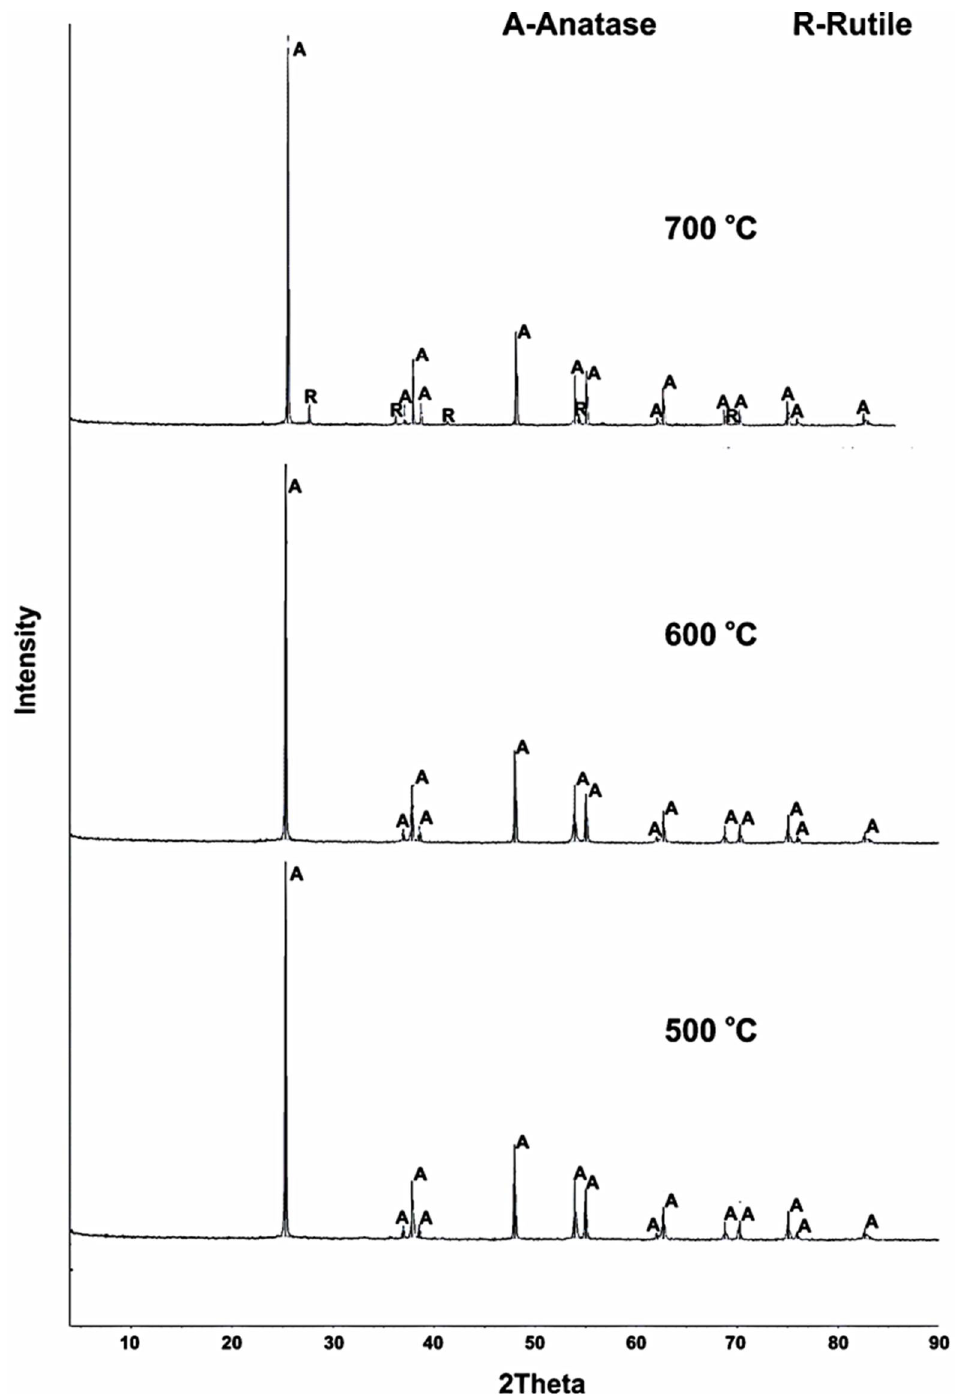
Figure 4. XRD patterns of titanium fluoride pyrolysis products (duration 300 min).